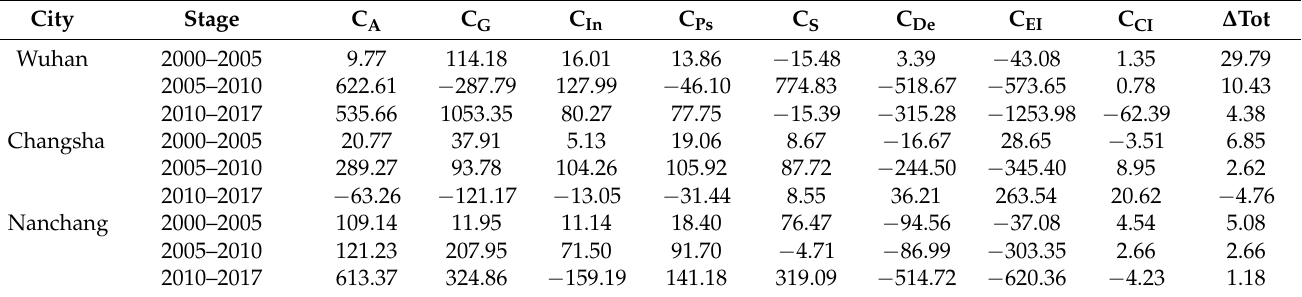
Table 3. Contribution of different factors to carbon emission from the three regions (units are %, Mt). City Stage C A C G C